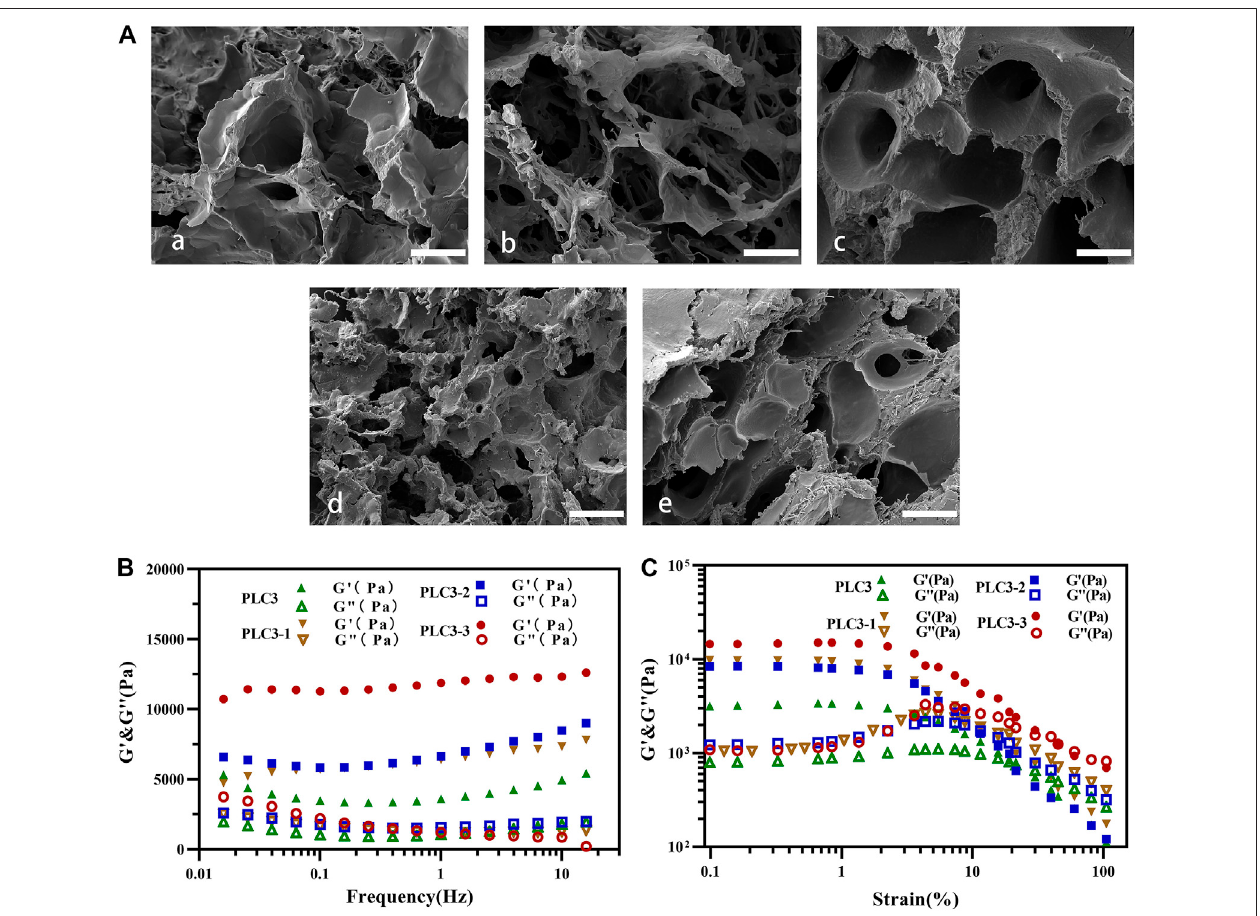
FIGURE 1 | SEM investigation for (A) a) blank hydrogel (without ε -PL), b) PLC3-3, c) PLC3-2, d) PLC3, and e) PLC3-1; scale bar: 20 μ m. Rheological results of PLC3, PLC3-1, PLC3-2, and PLC3-3 for (B) frequency sweep tests and (C) strain sweep tests.